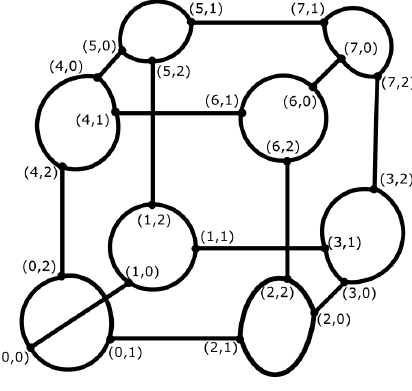
Figure 1. Three-dimensional Cube Connected Cycle